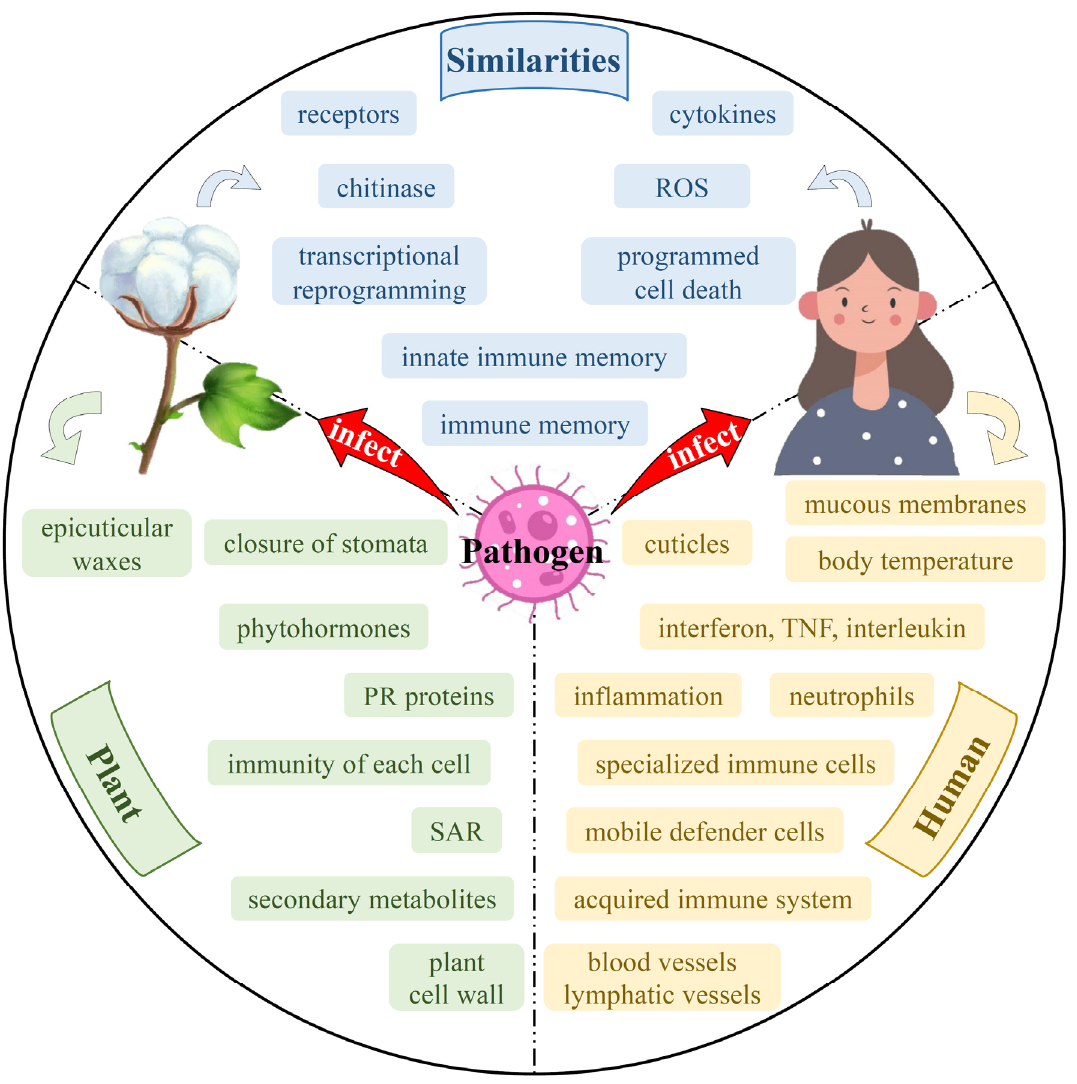
Figure 3. Similarities and differences in the resistance of plants (cotton) and humans to Fusarium . Blue represents the similarities between the defense mechanisms of plants and humans; green and yellow represent the respective characteristics of plants and humans. This cover has been designed using images from